Question: Write the caption for this figure.
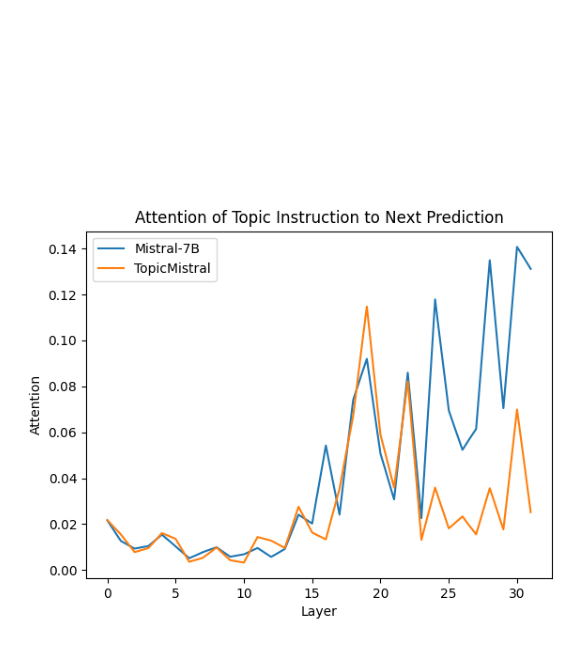
Answer: Average attention weight shift on Mistral-7B and TopicMistral. The x-axis represents the number of hidden layers and y-axis indicates the average attention weight from topic instruction to the next prediction to- ken.